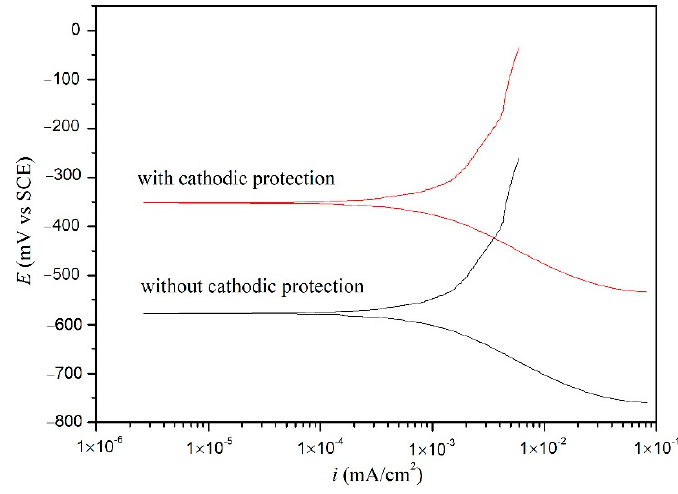
Figure 15. Polarization curves of the carbon steel without and with cathodic protection immersed in NSCS for 21 days. Table 4. Polarization parameters for carbon steel specimens in corrosion solution. Cathodic